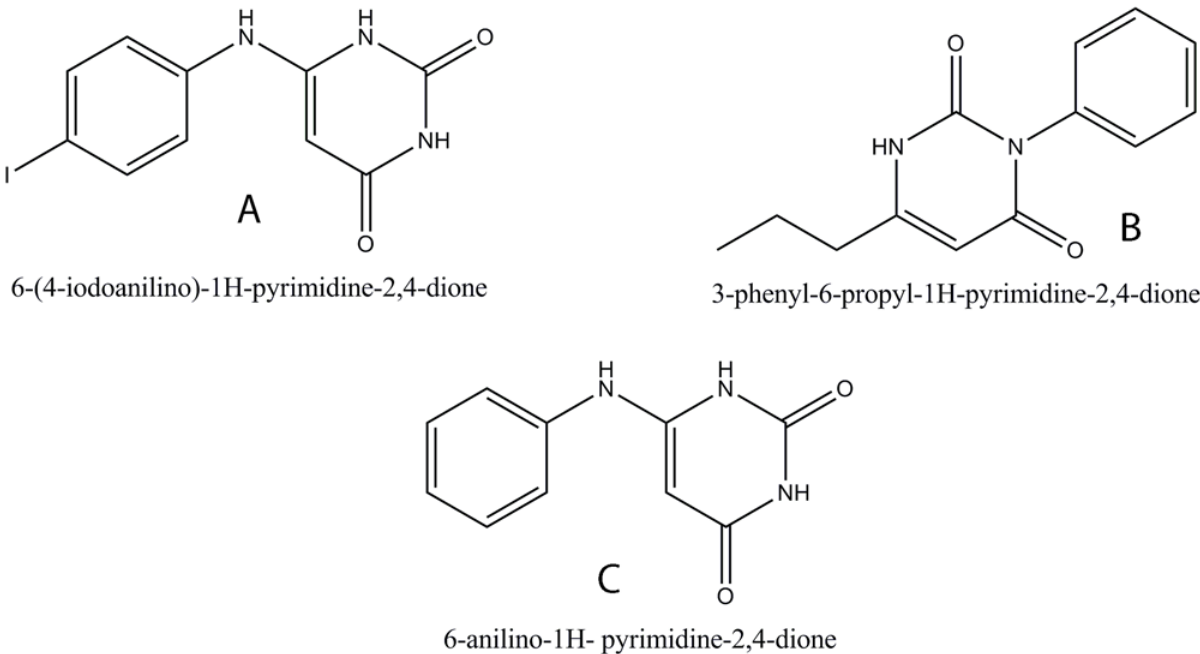
Fig 4. Structure of 6-AU and its Top Analogues (A) 6-(4-iodoanilino)-1H-pyrimidine-2,4-dione (C9), (B) 3-phenyl-6-propyl-1H-pyrimidine-2,4-dione (C10), (C) 6-anilino-1H- pyrimidine-2, 4-dione (6-AU) (control).